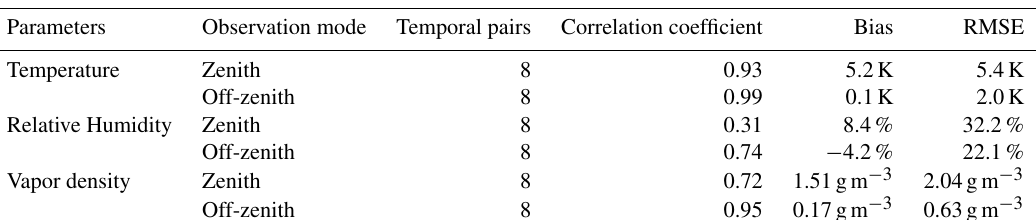
Table 2. Comparison of MWR retrievals against RABOs in zenith and off-zenith observations under snow conditions when not considering the difference in altitude.